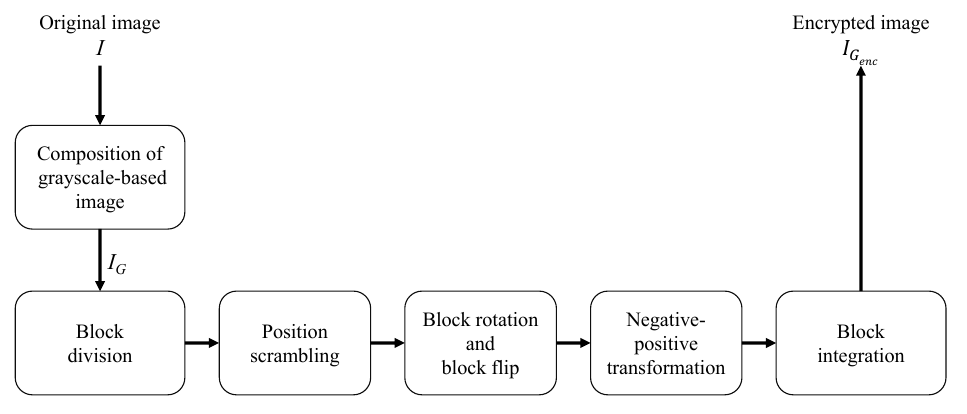
Figure 3. Block diagram of G-EtC method